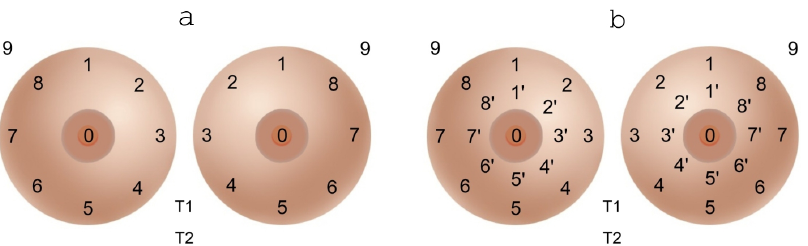
Figure 10. The scheme for measuring the temperature of the breast according to the standard method of MWR + IR examinations contains nine points on the surface of each breast (0,1,2, . . . ,8), an axillary point in the area of the lymph nodes (9), and two points at the sternum bottom (T1 and T2), which gives 22 points in total ( a ). The extended set of antenna location points on the breast surface proposed and studied by us in this paper contains 38 points ( b